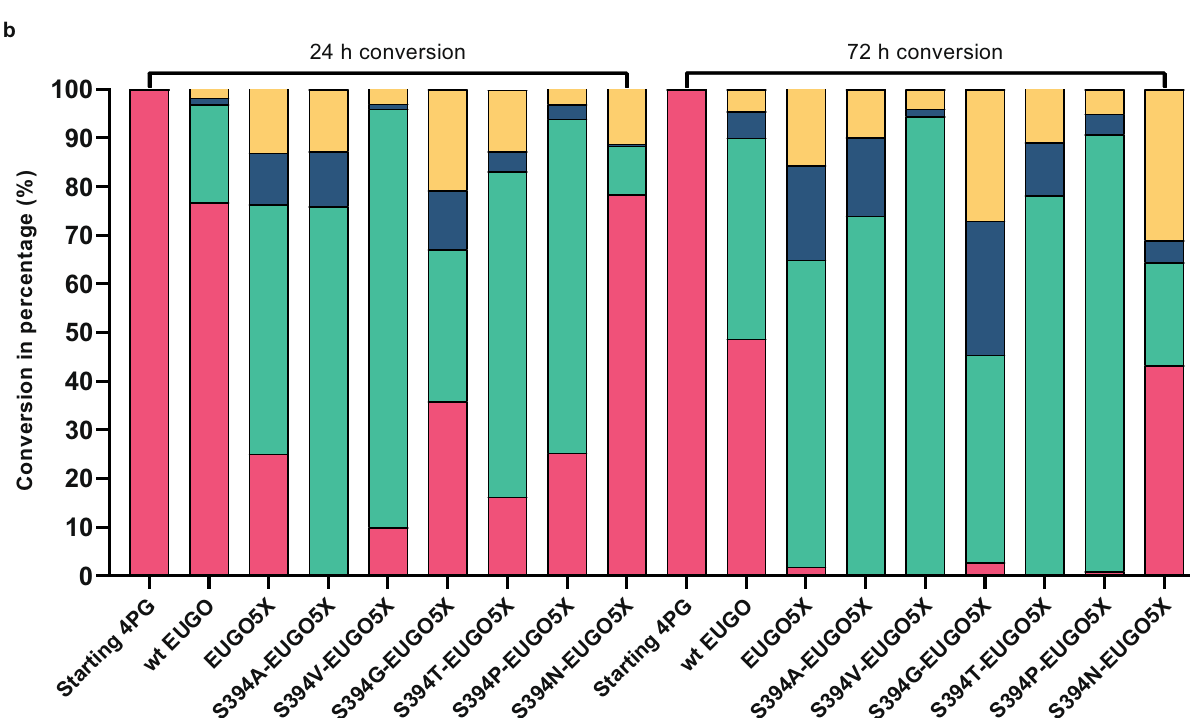
Fig. 4 | 4- n -propylguaiacol conversion by EUGO mutants. 4- n -propylguaiacol (4PG), isoeugenol (IEUG), 4-(1-hydroxypropyl) − 2-methoxyphenol (H4PG), 1-(4- hydroxy-3-methoxyphenyl) − 1-propanone (HPMP) are shown in red, green, orange andblue,respectively. a 24h4- n -propylguaiacolconversionbycell-freeextractsof